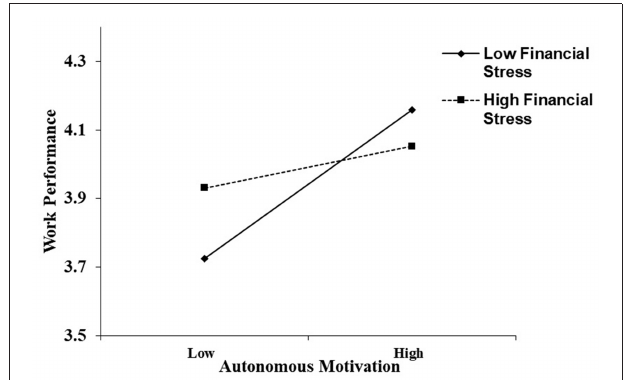
FIGURE 3 | Interaction effect of autonomous motivation and financial stress on innovative work behaviour. Conditional regressions of innovative work behaviour on autonomous motivation were conducted when financial stress was high ( M + 1 SD ) and low ( M − 1 SD ). Endpoints of the lines represented the scores of innovative work behaviour when autonomous motivation was low or